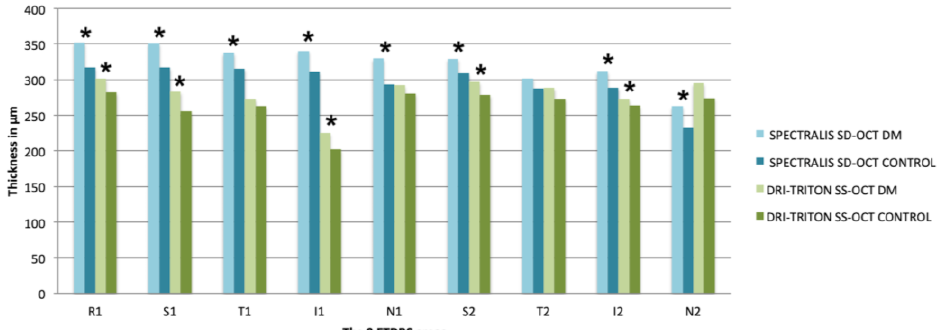
Figure 3. Mean of choroidal thicknesses in each ETDRS area expressed in μm measured with the Spectralis spectral domain optical coherence tomography (SD-OCT) and the deep range imaging (DRI)-Triton swept source optical coherence tomography (SS-OCT) in the type 1 diabetes Mellitus (DM1) group and the control group. Significant differences were considered as p < 0.05, calculated by Kolmogorov–Smirnov test for two independent nonparametric samples, are shown with *. SD-OCT, spectral domain optical coherence tomography; DRI, deep range image; SS-OCT, swept source optical coherence tomography; DM, diabetes mellitus; ETDRS, Early Treatment Diabetic Retinopathy Study; R1, central; S, superior; T, temporal; I, inferior; N, nasal. The number 1 corresponds to the 3 mm parafoveal inner circle and 2 to the 6 mm perifoveal outer circle.